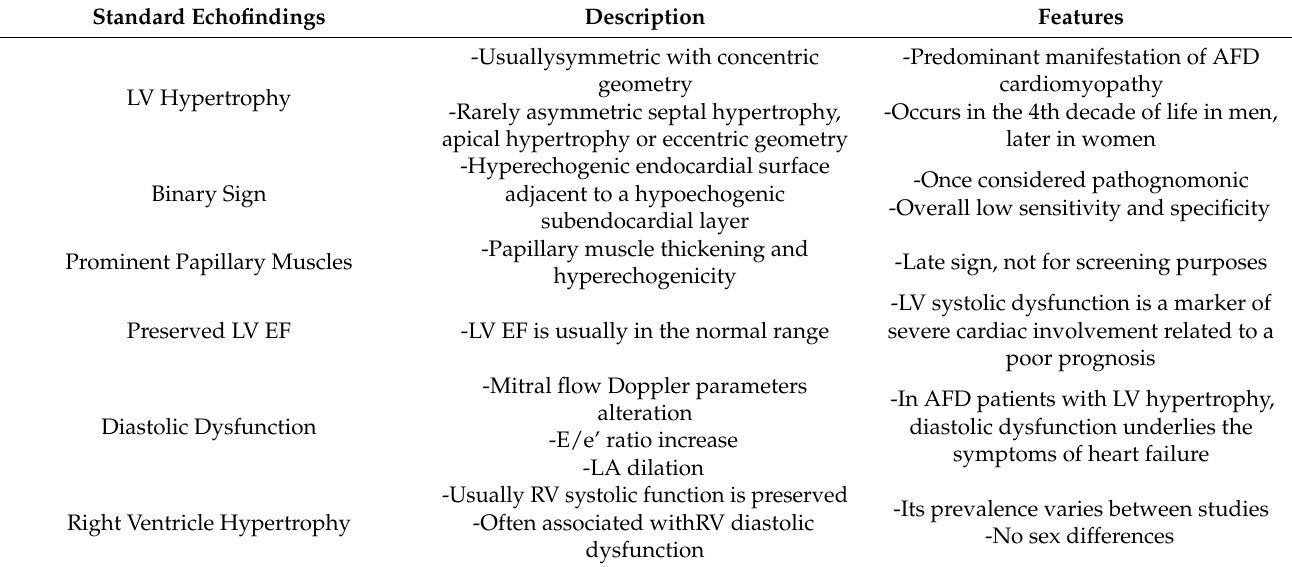
Table 1. Standard echocardiography in ADF